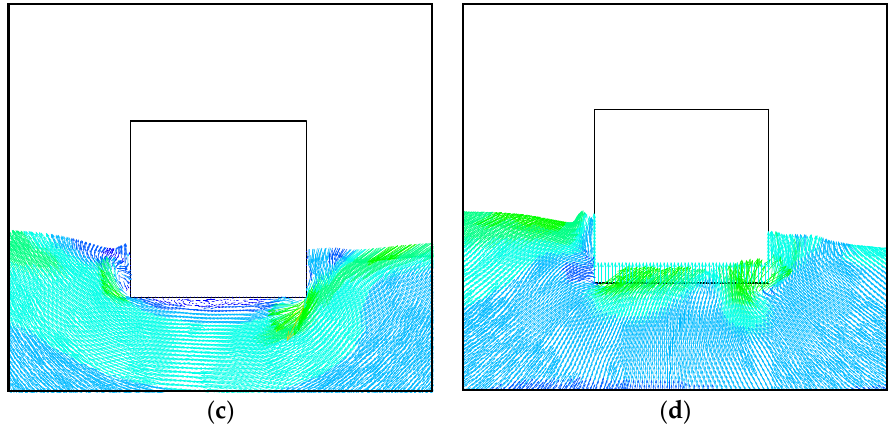
Figure 13. Flow fields around the buoy in a wave cycle ( S = 0.25, H = 0.1 m, T = 1.75 s): ( a ) t = T/4; ( b ) t = 2T/4; ( c ) t = 3T/4; ( d ) t = 4T/4.